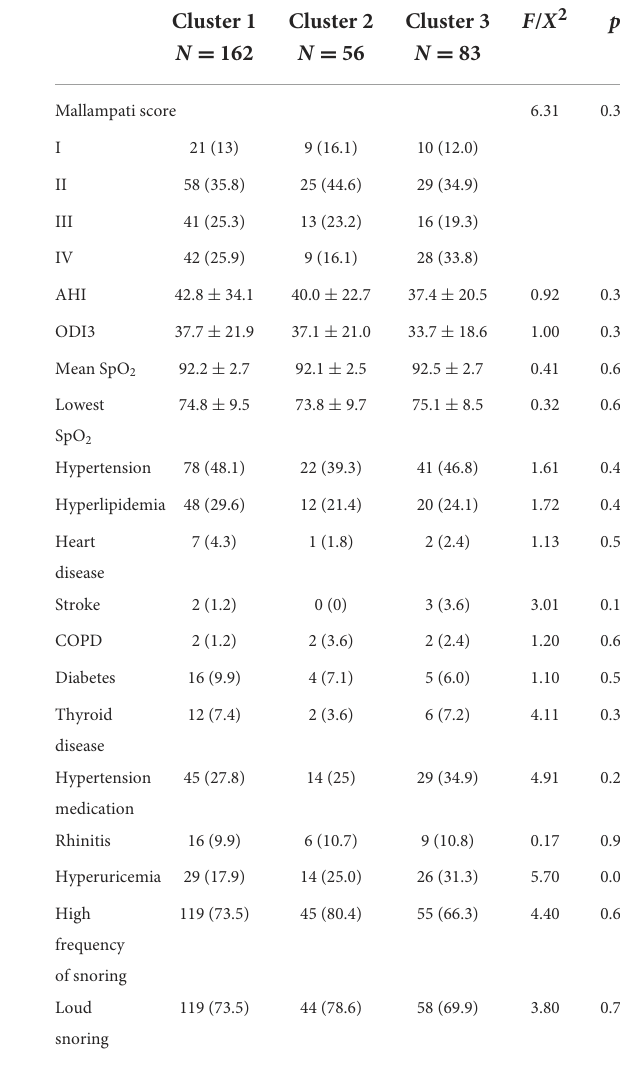
TABLE 3 Demographic characteristics of three patterns of adherence. TABLE 4 Characteristics of comorbidities and disease severity among three